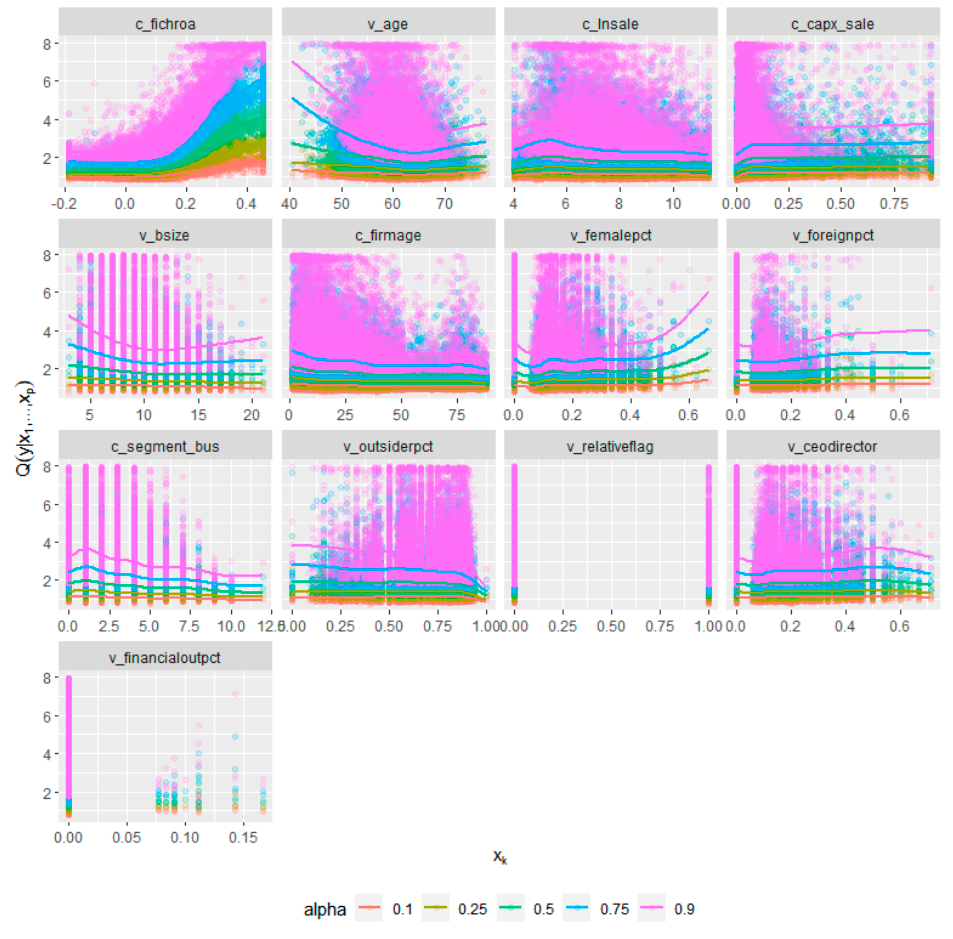
Figure 5. Plots for Copula based Quantile Regressions (Parametric).